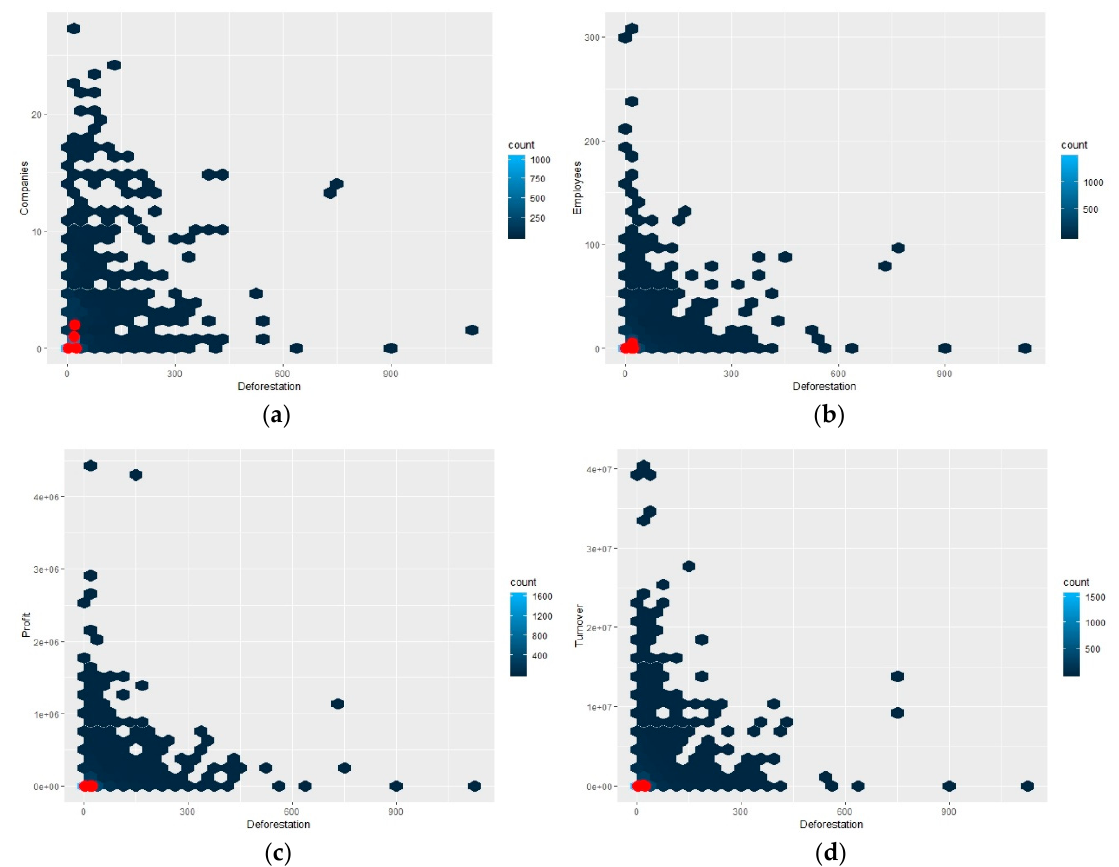
Figure 6. Hexbin plot revealing a 2 ‐ dimension spatial distribution of ( a ) number of companies; ( b ) number of employees; ( c ) values of profit; ( d ) values of turnover, where the color ‐ scheme defines the abundance of values.